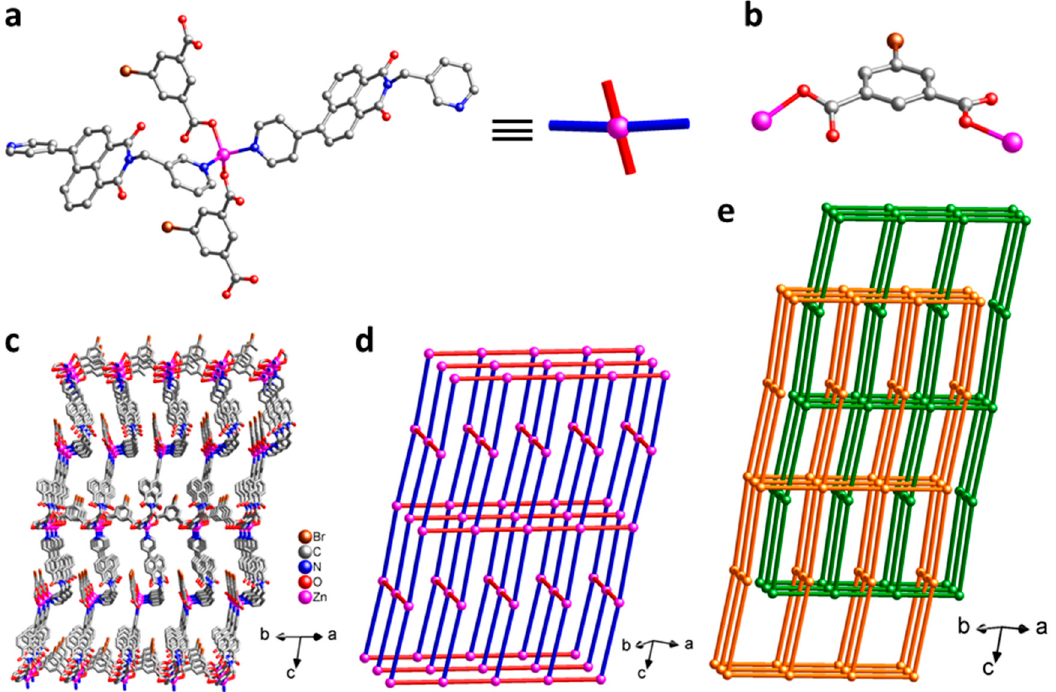
Figure 1. Crystal structure of 1 : ( a ) the coordination environment around the Zn(II) center and schematic representation of the 4-connected node; ( b ) the coordination mode of Br-1,3-bdc 2 ‒ dianion; ( c ) a single 3-D framework; ( d ) schematic representation of the 4-connected cds network with the point symbol of (6 5 ∙ 8); ( e ) 2-fold interpenetrating cds networks.